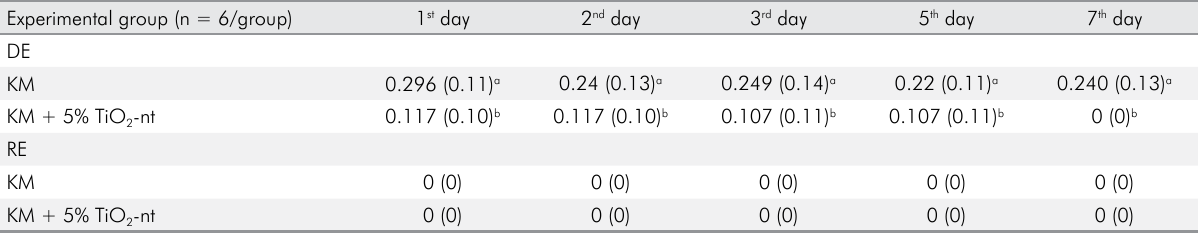
Different letters indicate a statistically significant intergroup difference (p <0.0001, KM versus KM+5% TiO2); KM: Ketac Molar EasyMix (control); TiO2-nt: titanium dioxide nanotube; DE: demineralizing solution; RE: remineralizing